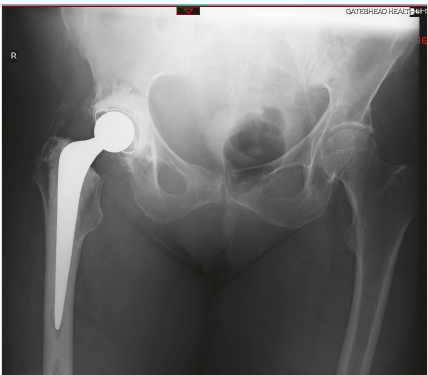
Figure 1: Plain X-ray of the right hip with normal soft tissues and satisfactory position of prosthesis.